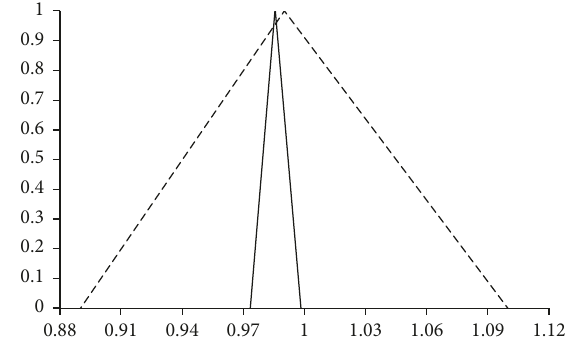
Figure 1: The fuzzy values of the left hand side (dashed curve) and the right hand sides (solid curve) of